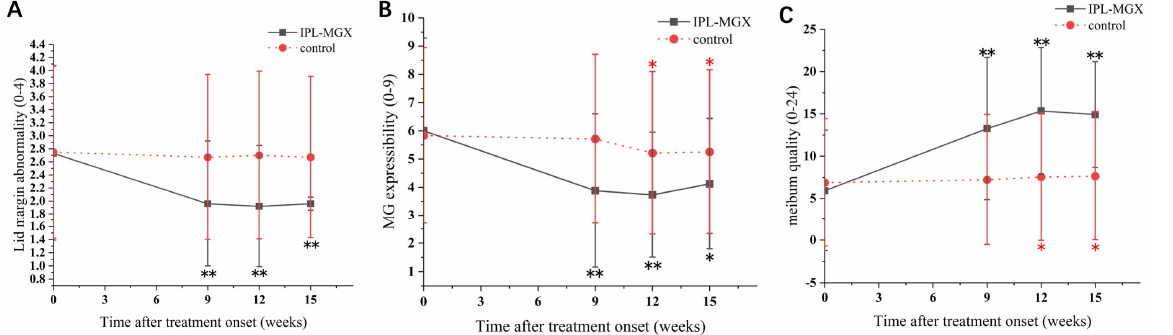
Figure 4. Time course of eyelid margin abnormalities, meibomian gland expressibility (MGX), and meibum quality in the intense pulsed light (IPL)–meibomian gland expression (MGX) and control groups. ( A ) Changes of lid margin abnormality before and after treatment. ( B ) Changes of MGX before and after treatment. ( C ) Changes of meibum quality before and after treatment. All follow-up assessments were compared to the baseline (time 0) values (* p < 0.05, ** p < 0.001). We found similar Snellen BCVA, conjunctival congestion, TMH, and SIT at weeks 9, 12, and 15 in the two groups. MG dropouts did not change over the four visits in either group (all p > 0.05). The KCS ‐ specific symptoms have improved following the IPL ‐ MGX treatment. Fig ‐ ures 5 and 6 show two representative cases of patients with SS ‐ DE in the IPL ‐ MGX group who exhibited significant improvement in their ocular surface conditions between base ‐ line and the final follow ‐ up visit. Both patients had notable ocular surface inflammation, poor vision, and could barely open their eyes before treatment (Figures 5A–D and 6A–D). Case 3 (Figure 5) was a 60 ‐ year ‐ old female with SS for 14 years and DE for 13 years. The patient was previously treated with topical and oral corticosteroids, topical cyclosporine, and autologous serum, but none achieved disease progression control. The patient showed severe symptoms including strong foreign body sensation, burning, stinging, photophobia, blurred vision, and ocular pain. Case 11 (Figure 6) was a 36 ‐ year ‐ old female with SS for 7 years and DE for 5 years. The patient had similar ocular irritation symptoms as in case 3. Previously treatments with topical corticosteroids, cyclosporine, artificial tear eye drops, warm compresses combined with MGX, and eyelid hygiene had failed. Re ‐ duced filamentary keratitis, corneal epithelial healing, and improved vision were noted at last follow ‐ up in both cases (case 3: Figure 5E–H, case 11: Figure 6E–H).